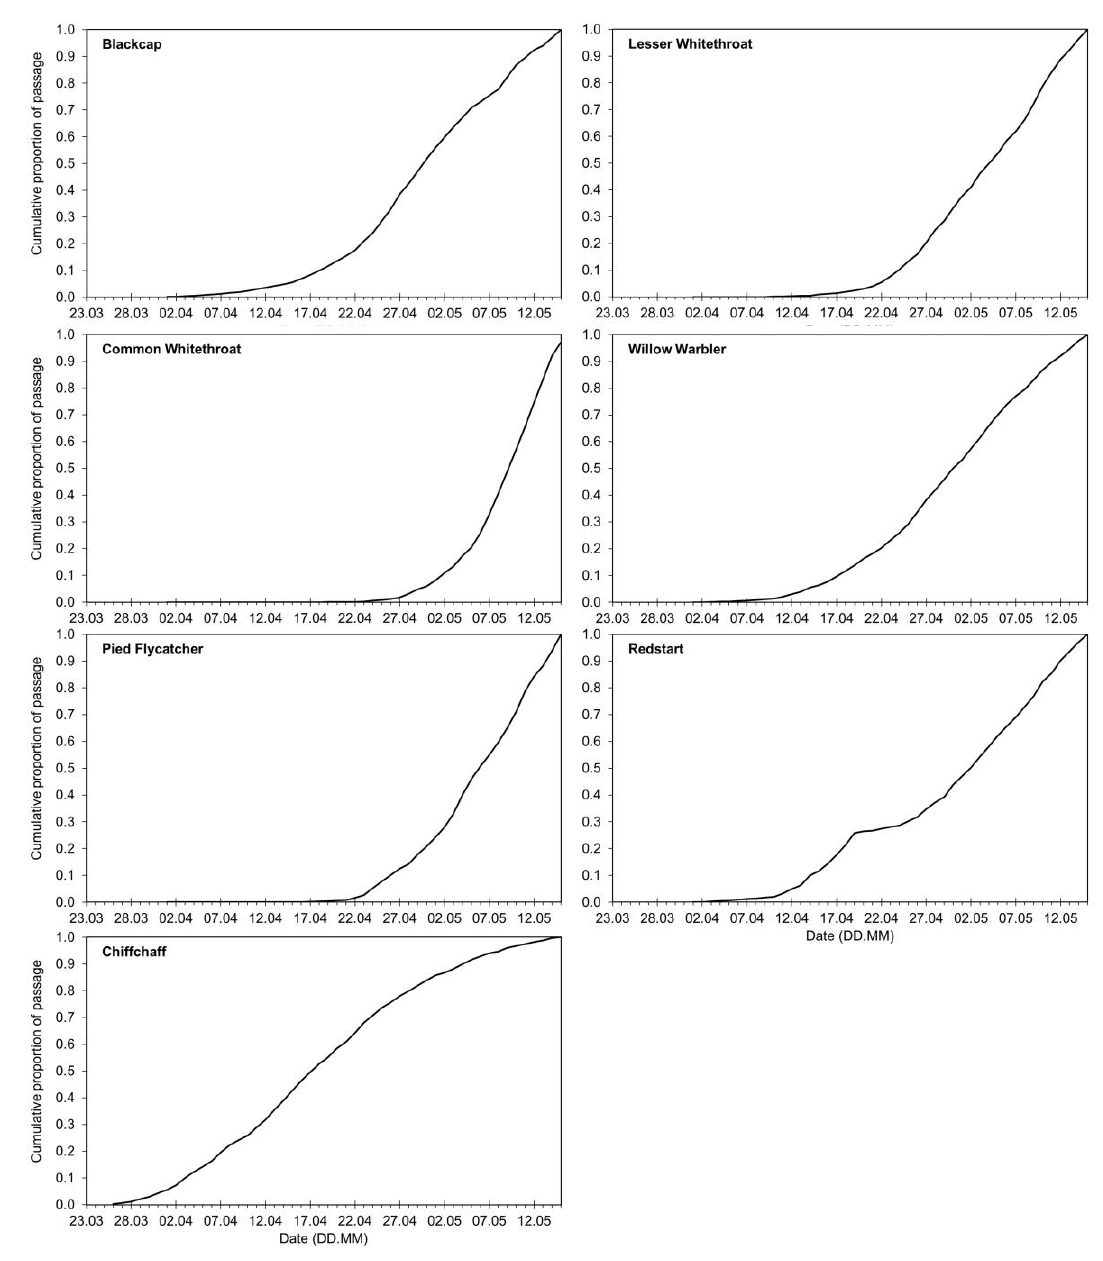
Figure 2. Many-year average cumulative curves of spring arrivals at Bukowo, Poland, over 1982–2021 for the analysed